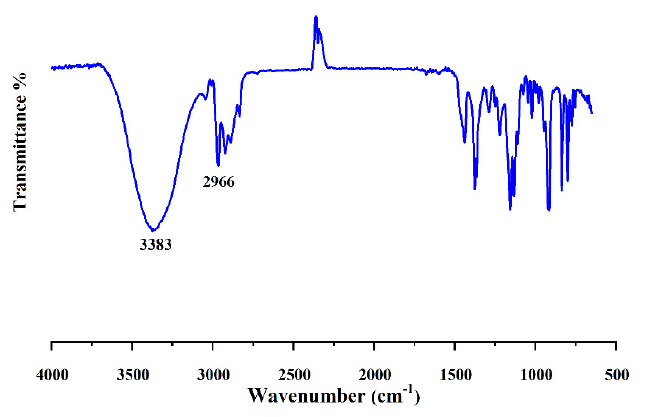
Figure 1. FTIR spectrum of α − terpineol.